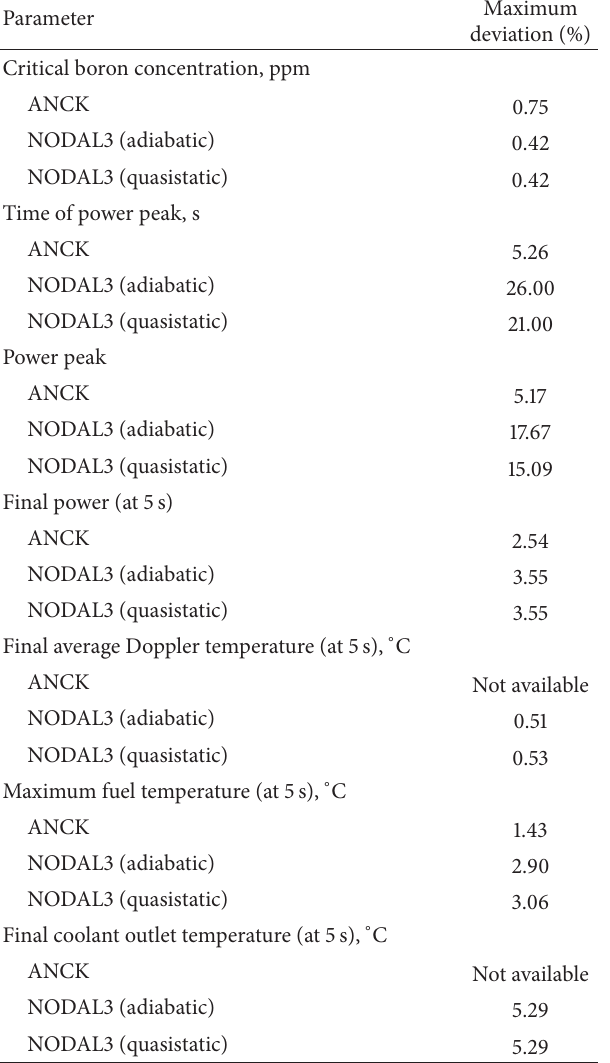
Table 4: Maximum deviations of ANCK and NODAL3 compared to the reference solution in 1997